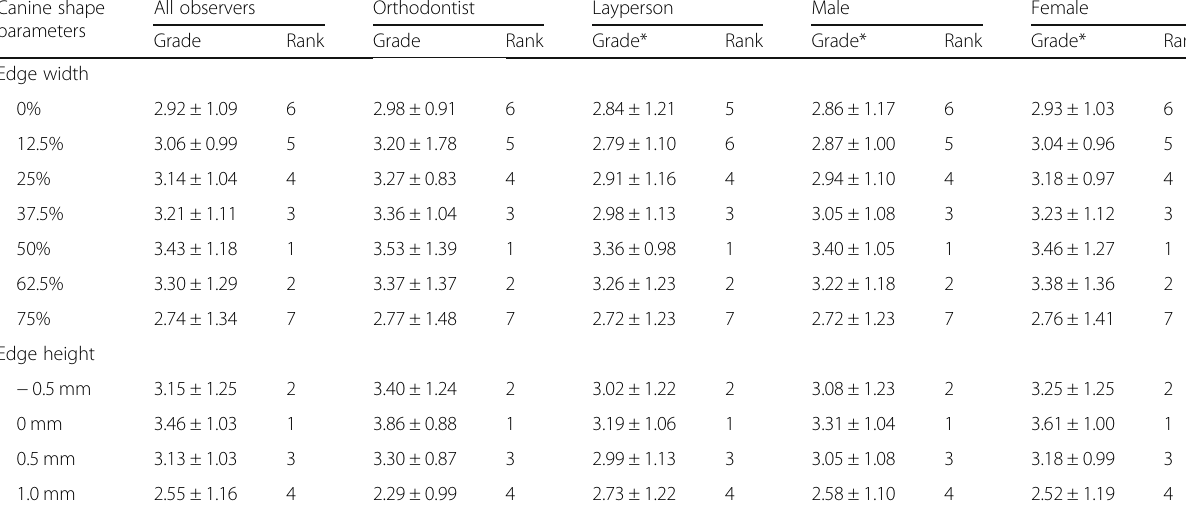
*Data represent mean±standard